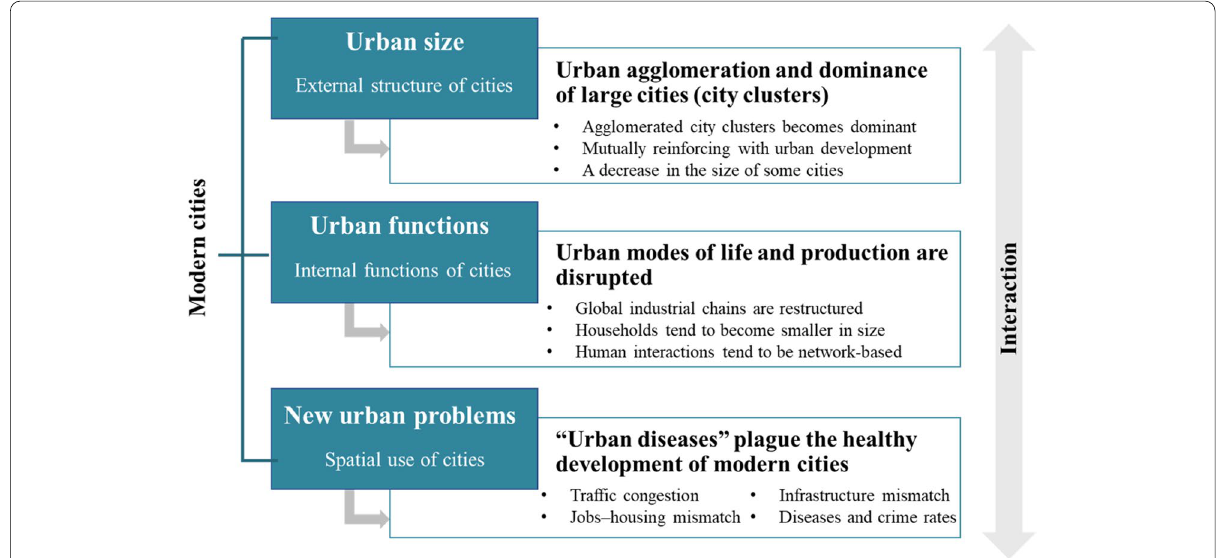
Fig. 1 The key characteristic components of modern